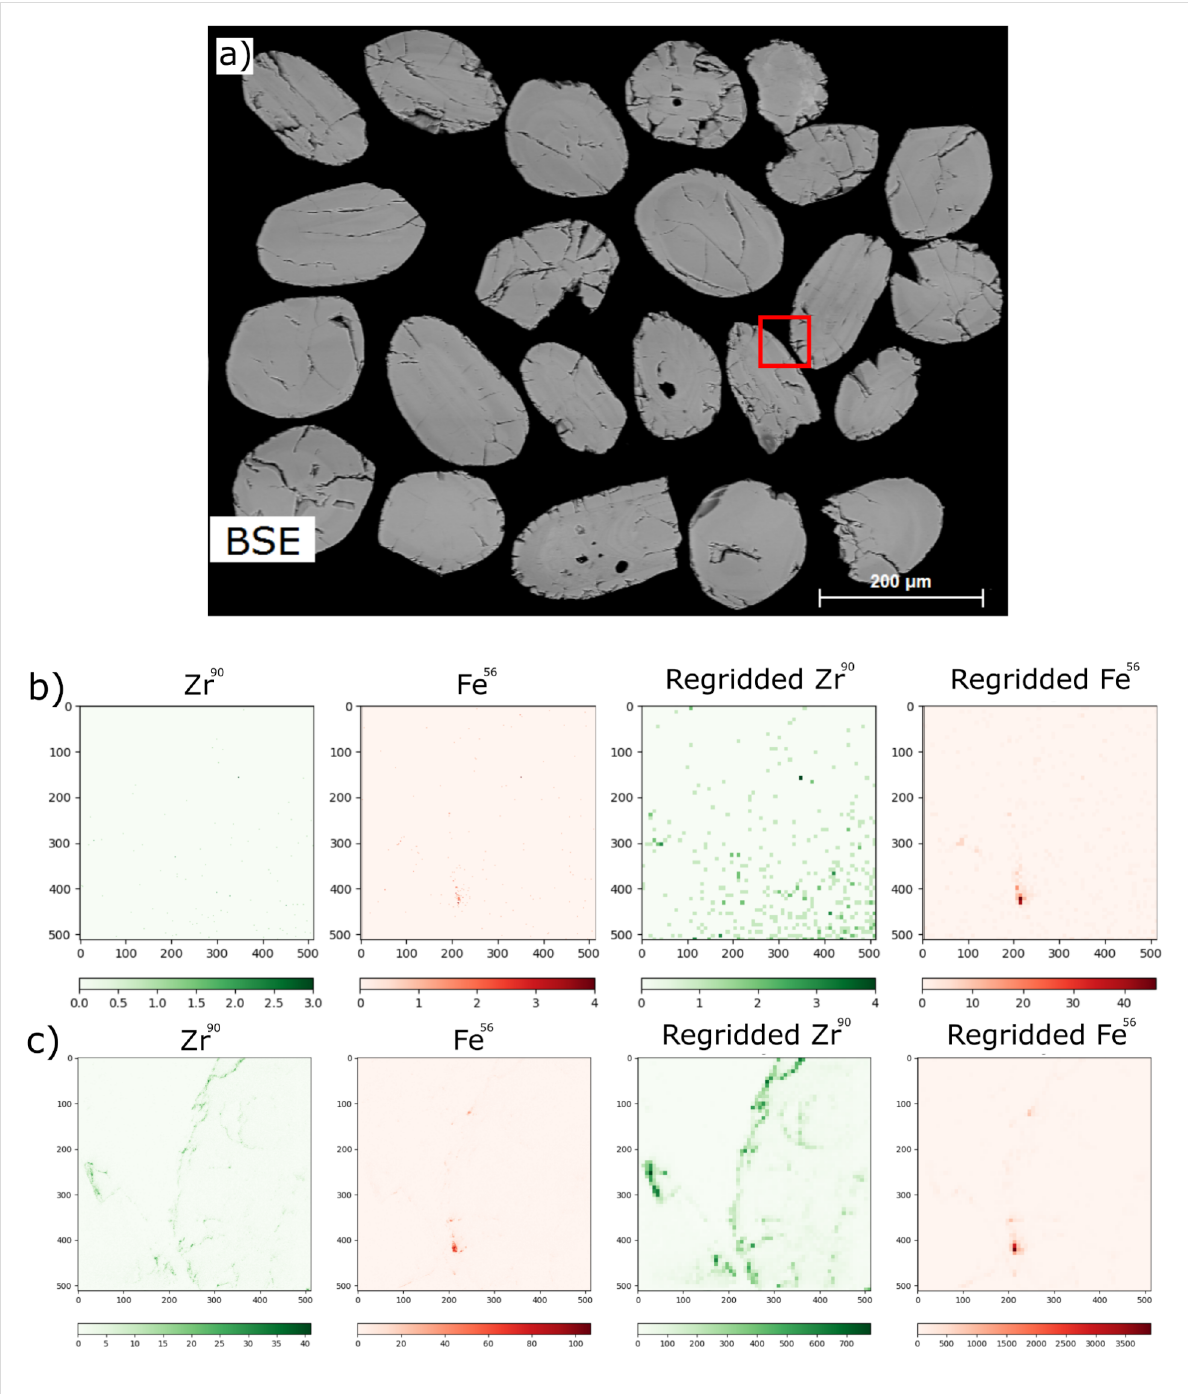
Figure 2: a) Backscattered electron (BSE) map of the sample, SIMS location outlined in red; b) raw and processed 90 Zr and 56 Fe mass images after 20 min of rastered beam exposure on the sample; c) raw and processed 90 Zr and 56 Fe mass images after 240 min of rastered beam exposure on the sample. Initial maps were 512 × 512 pixels, covering a field of view of 70 µm. The scales show the absolute number of ions